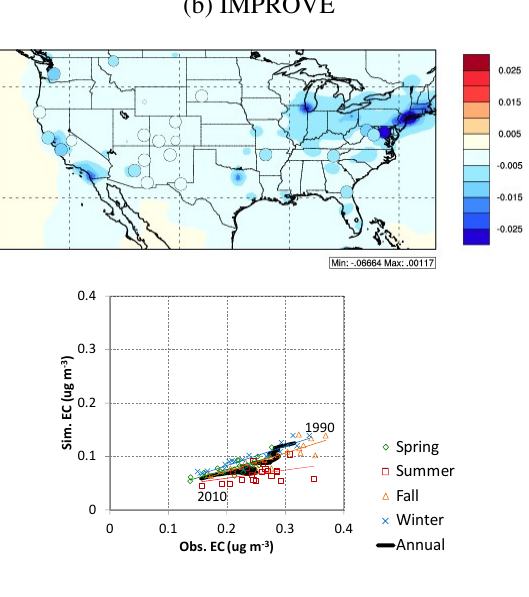
Figure 9. Same as Fig. 3 for